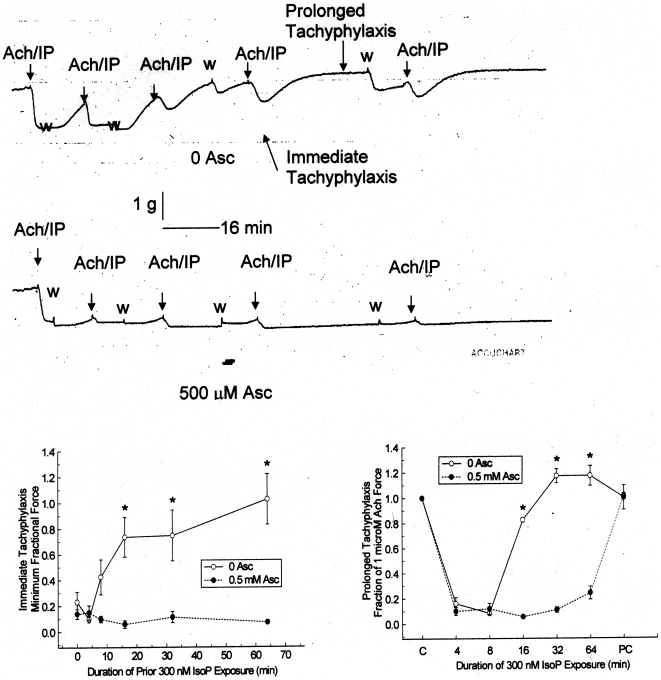
Effect of ascorbate on tachyphylaxis of 30 nM isoproterenol (IP) relaxation of 1 µM acetylcholine (Ach) contractions of guinea pig tracheal rings.Upper panels: chart records of progressive contractions in the presence of 0 and 500 µM Asc. The Ach/IP indicates the addition of Ach and IP. The w indicates the washout of Ach and IP. Lower panels: Quantitation of immediate and prolonged tachyphylaxis. The immediate tachyphylaxis measurements are plotted as a function of the duration of IP exposure of the immediate prior application. The prolonged tachyphylaxis measurements are plotted as a function of the duration of the IP application. The C (control) and PC (post-control) in the prolonged graph (lower panel) are the forces generated by the tissue prior to and following the Ach/IP applications, respectively. Values are mean ± SE. The open symbols are 0 Asc; the filled symbols are 500 µM Asc. The * indicates a significant difference (p<0.05) from the 0 Asc data.